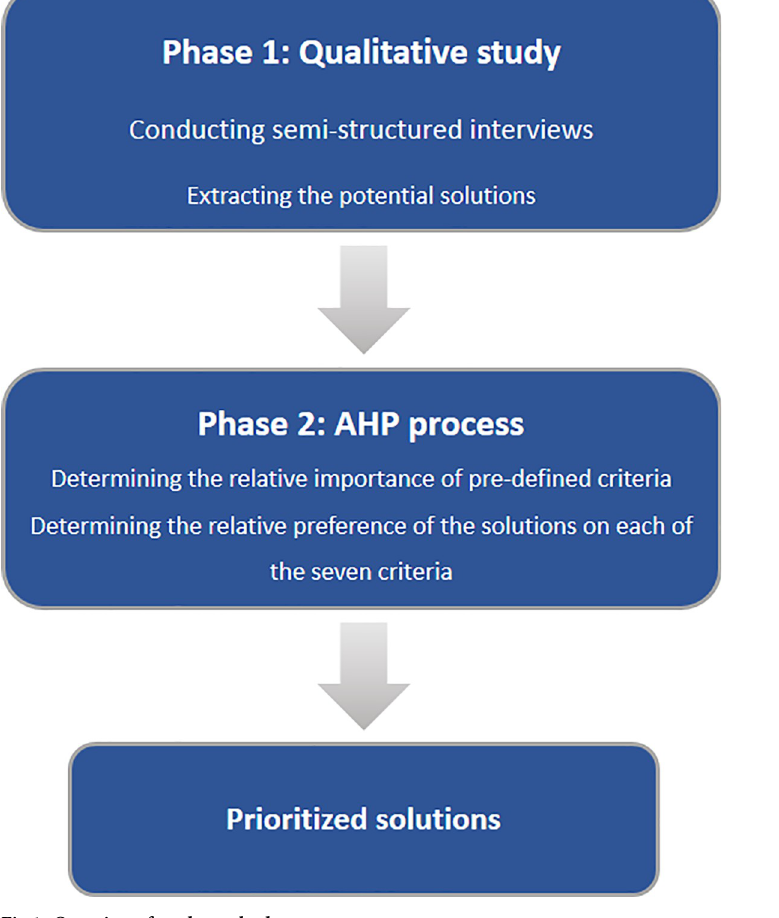
Fig 1. Overview of study